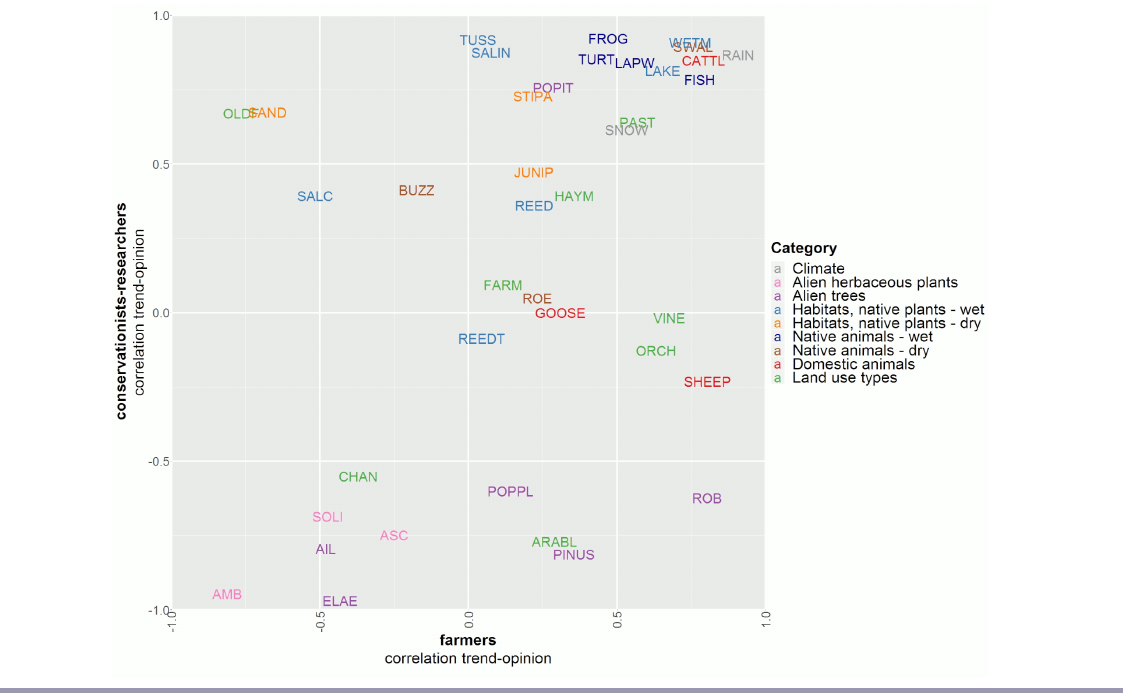
Fig. 5 . Spearman correlation between perceived trends and opinions of farmers and conservationists-researchers. In the case of positive correlation, opinions of reductions are negative, and opinions of increases are positive; whereas in the case of negative correlation, decreases are valued positively, and increases negatively. Along the diagonal axis from lower left to upper right, farmers and conservationists-researchers share similar reactions to landscape changes. In the upper left corner are phenomena more positively valued by conservationists-researchers, while the lower right corner features landscape elements more positively valued by